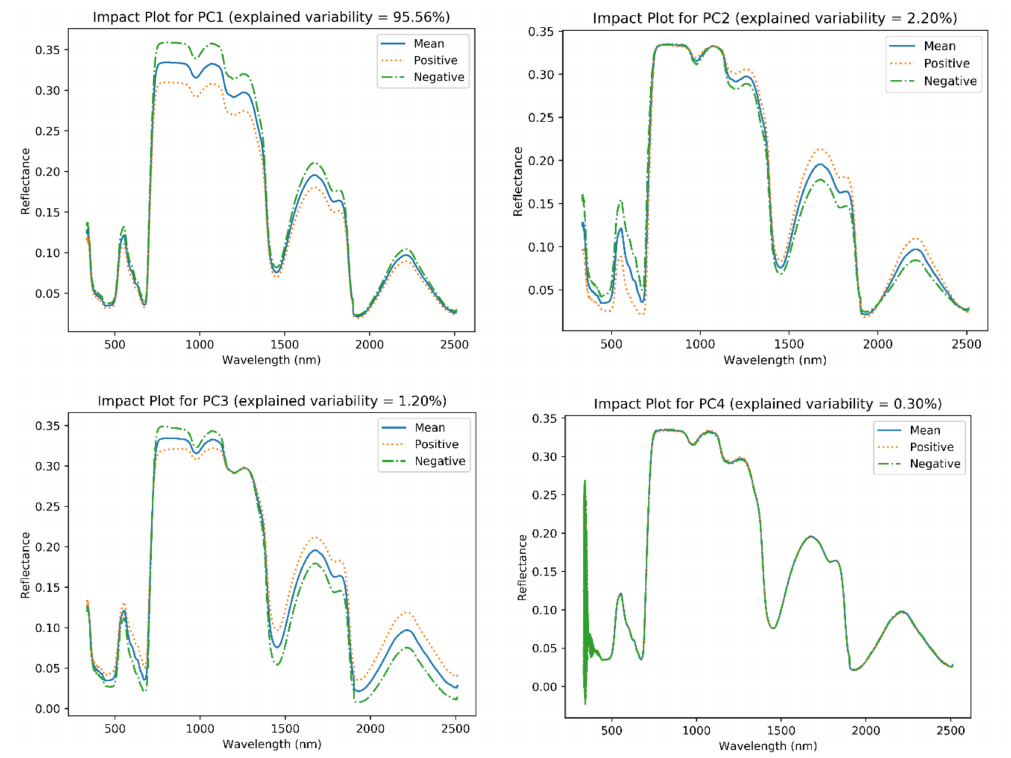
Figure 6. Impact plots for first four principal components and their corresponding explained variability.